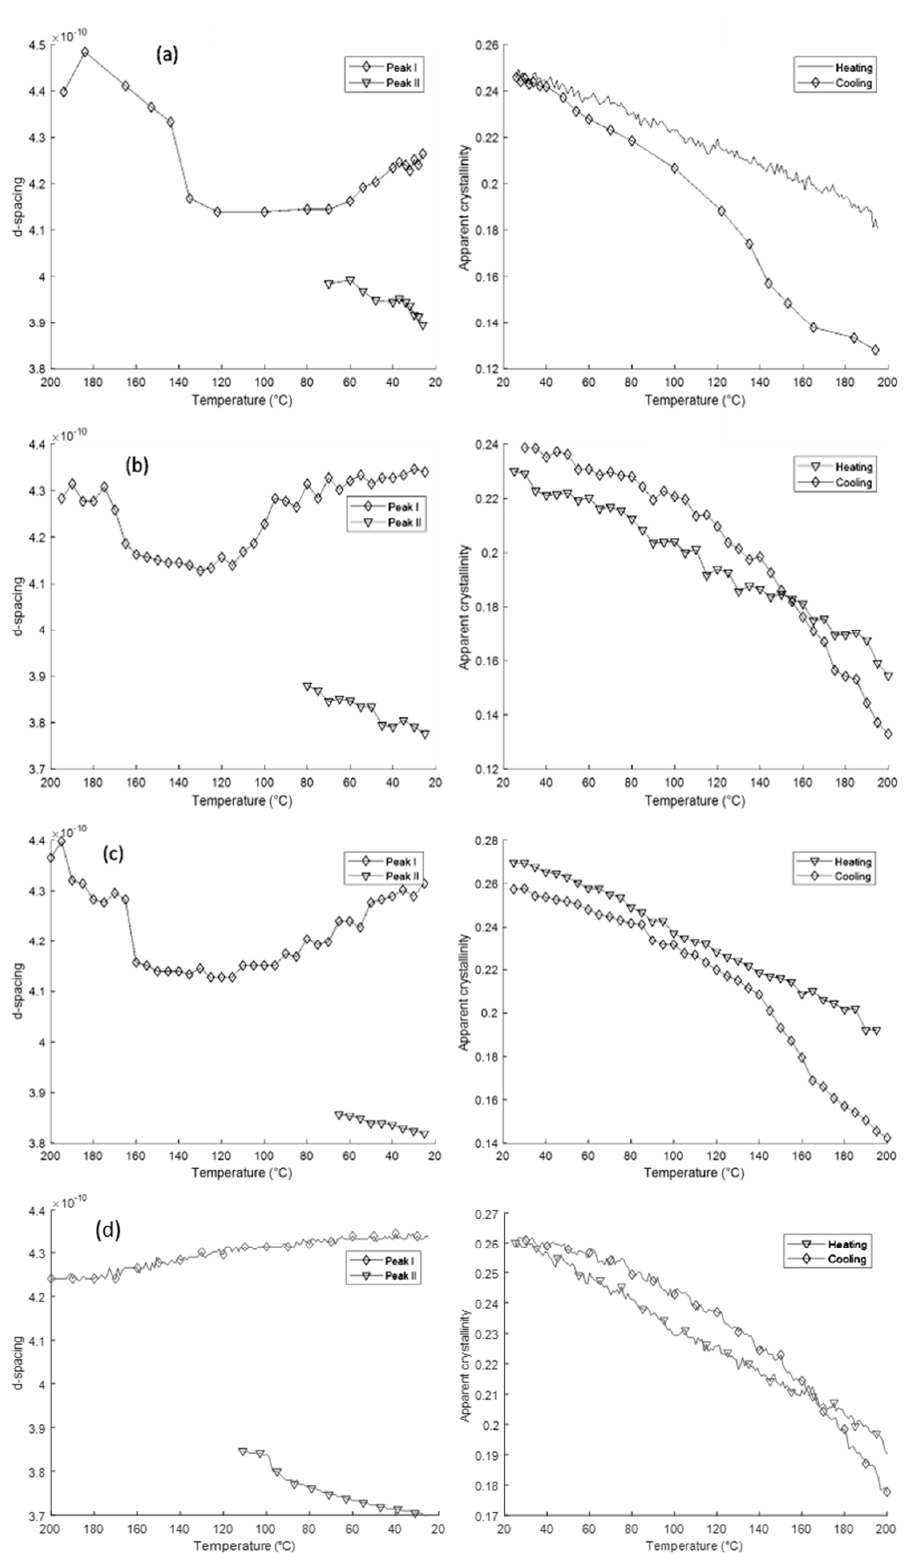
Figure 6. The evolution of the lattice d -spacing during cooling for the two peaks present shown alongside the percentage of crystallinity derived from X-ray analysis during heating and cooling. ( a ) Sample I, ( b ) Sample II, ( c ) Sample III, ( d ) Sample IV.